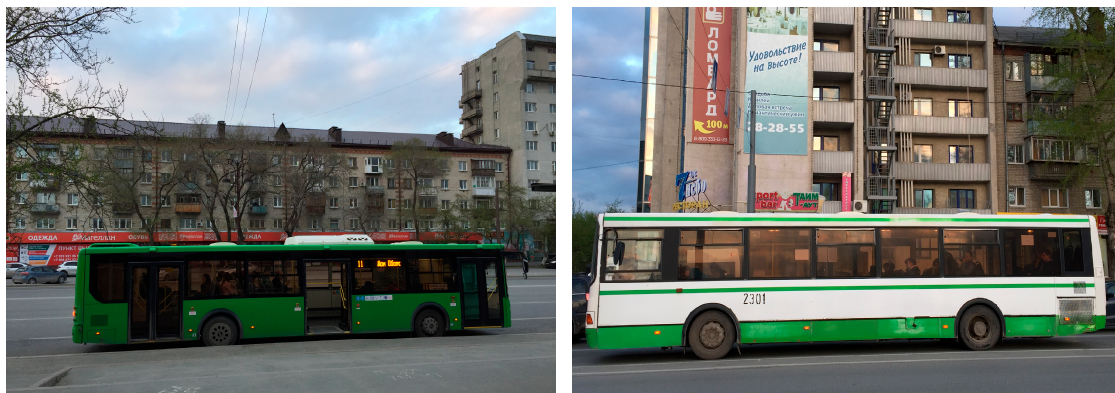
Figure 6. Silhouette photo of compartment filling of buses on Tyumen routes during an acute phase of COVID-19 in April 2020.